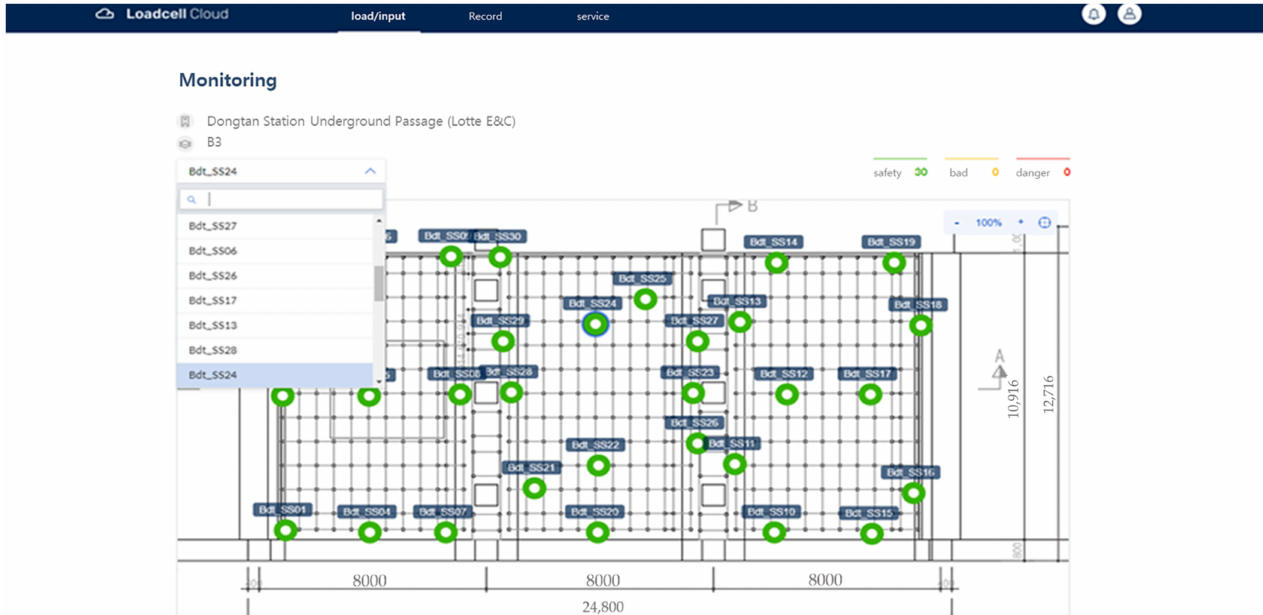
Figure 18. Uploading of the construction drawings.